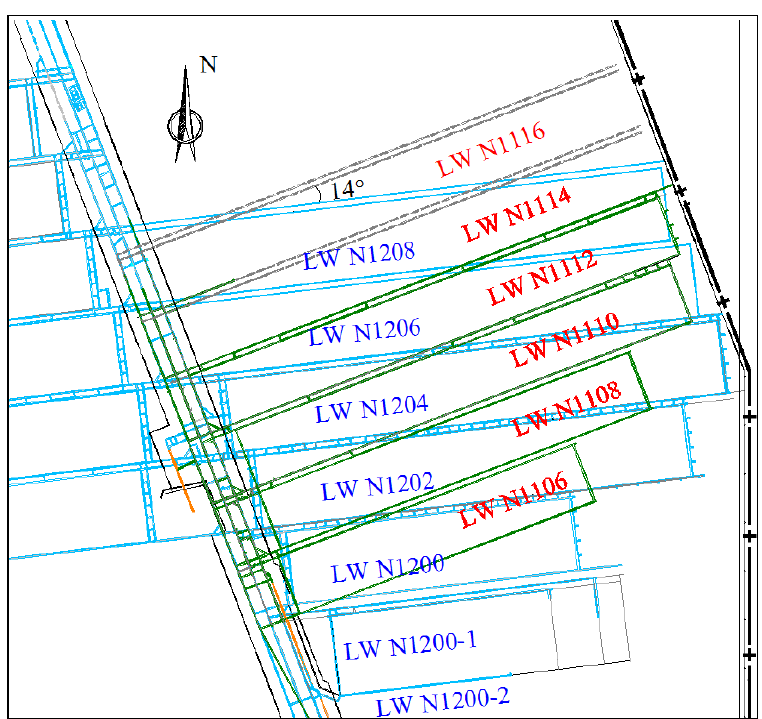
Figure 2. The longwall face arrangement in northward east area. Table 1. The parameters of coal and its roof and floor.